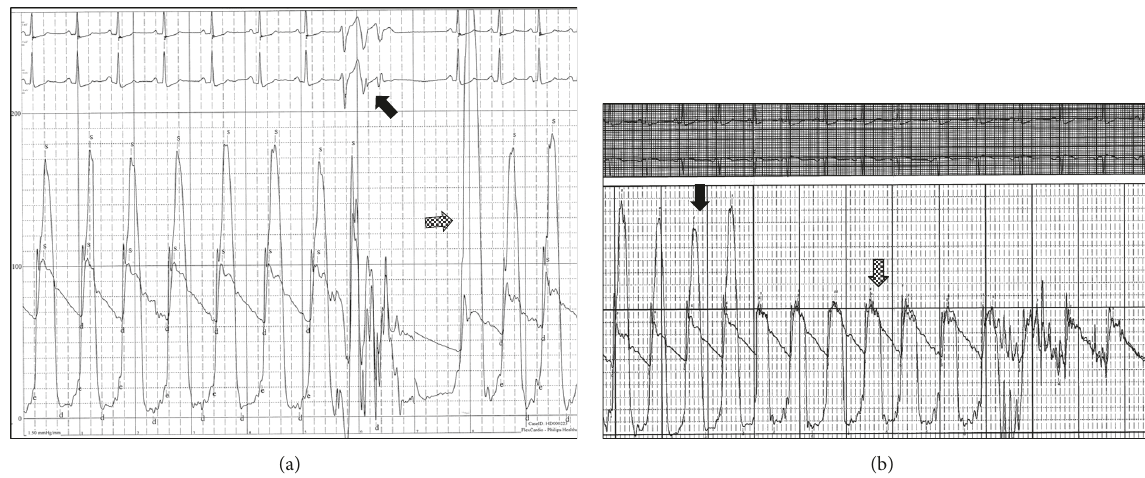
Figure 2: Hemodynamic tracings at cardiac catheterization. (a) Simultaneously measured aortic and LV pressures using a dual lumen pigtail catheter demonstrate an 84 mmHg resting peak-to-peak gradient. The aortic waveform shows a spike-and-dome pattern, and the LV waveform is late-peaking. After premature ventricular contractions are provoked (black arrow), the postextrasystolic beat demonstrates a reduction in aortic pulse pressure with a worsening in peak-to-peak gradient to 160mmHg (checkered arrow). This finding is consistent with dynamic LVOT obstruction. (b) Pullback tracing with the dual lumen pigtail catheter starting in the mid LV cavity (black arrow) and then being withdrawn to just beneath the aortic valve (checkered arrow) demonstrating normalization of the large gradient. This suggests that the site of obstruction is within the LVOT.